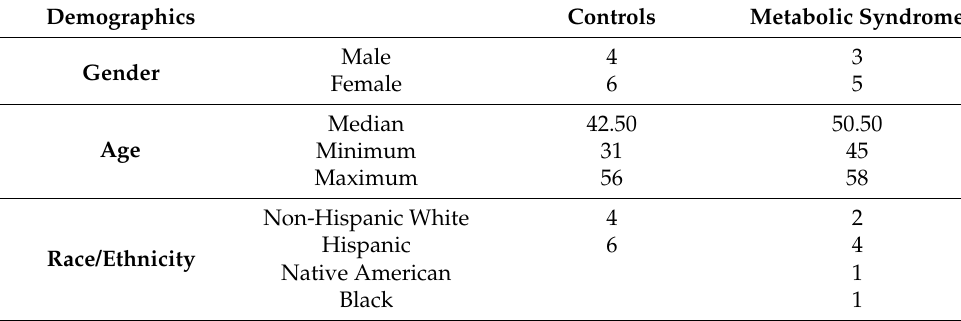
Table 1. Demographics of study